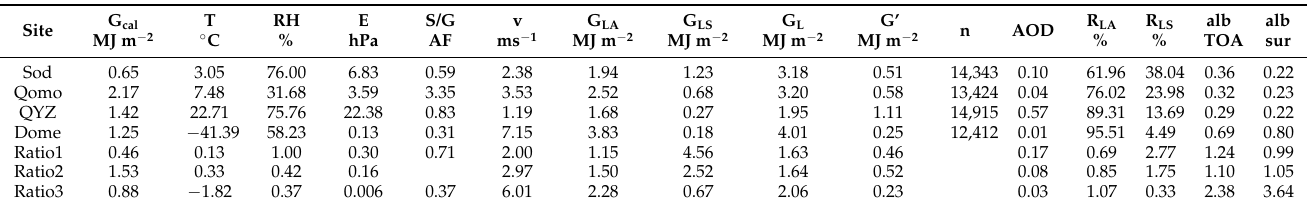
Table 8. Annual averages of observed monthly meteorological variables and S/G and simulated monthly global solar irradiance and its loss, albedos at the TOA and the surface, AOD, and sample number (n) at Qomolangma (referred to as Qomo), Sodankylä (Sod), Dome C (Dome), and QYZ sites under all-sky conditions during 2013–2016, and the ratios of all parameters between Sodankylä and QYZ, Qomolangma and QYZ, and Dome C and QYZ (ratio 1, ratio 2, and ratio 3) (alb and sur denote albedo and surface, respectively). AF is for Qomolangma